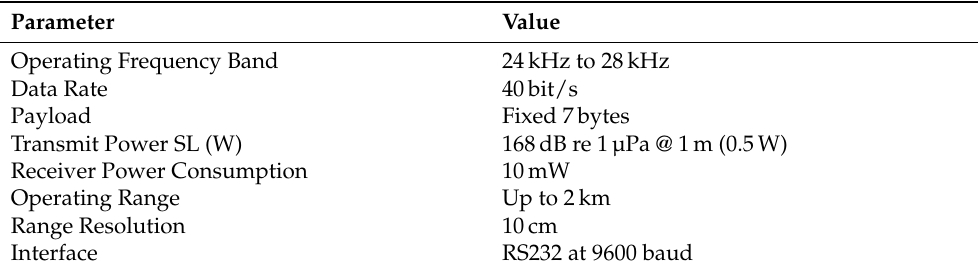
Table 1. NMv2 Characteristics and